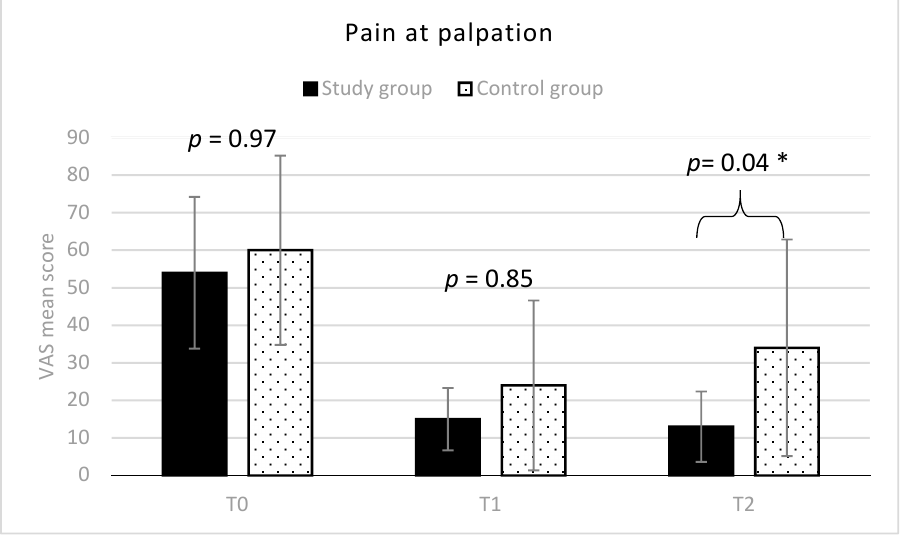
Figure 2. Muscle pain at palpation (mean VAS scores and SD) in the two groups. * indicates between groups statistically significant differences ( p < 0.05).